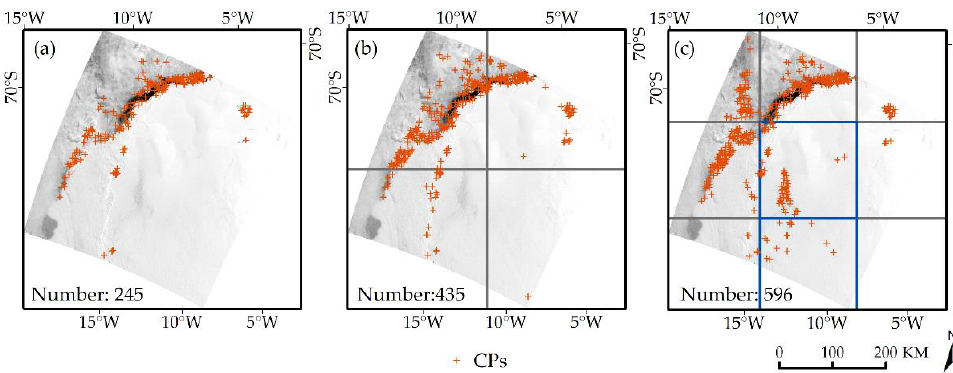
Table 2. The number of the extracted CPs with different image division schemes. Number of CPs Extracted from Sample Image Figure 7. Schematic diagram of the number and distribution of the CPs extracted by different division strategies. ( a ) The original image; ( b ) Scheme 1; ( c ) Scheme 2.